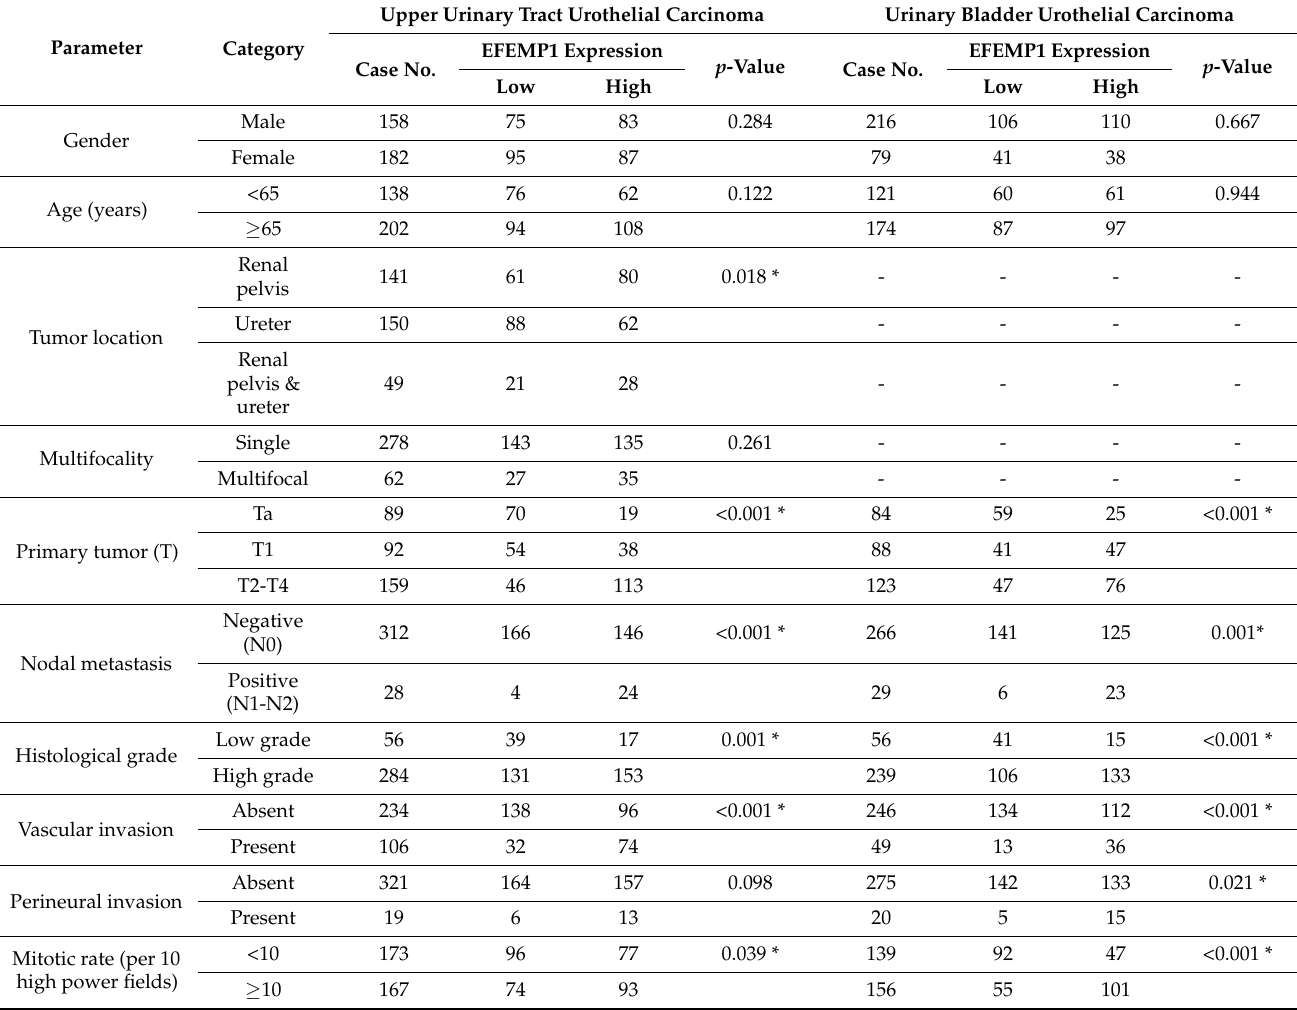
Table 2. Correlations between EFEMP1 Expression and other important clinicopathological parameters in urothelial carcinomas.